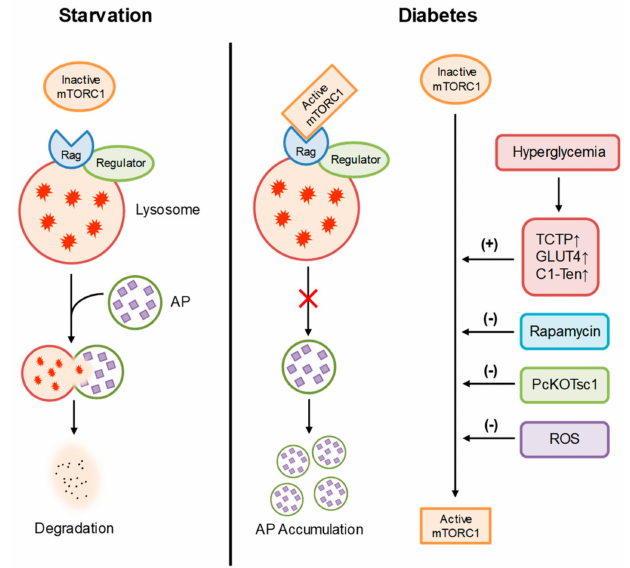
Figure 2. Regulation of mTORC1 in podocytes. During starvation, inactive mTORC1 has no e ff ects on lysosome function and autophagic flux in podocytes. During diabetic nephropathy (DN), hyperglycemia upregulates TCTP, GLUT3, and C1-Ten, leading to overactivation of mTORC1 and inhibition of autophagy. As a specific mTORC1 inhibitor, rapamycin can prevent lysosome dysfunction, autophagic deficiency, and podocyte injury during diabetes. Reactive oxygen species (ROS) produced by mitochondria has also been reported to prevent mTORC1 activation in podocytes during diabetes. Lysosome membrane permeabilization (LMP) has been found to initiate lysosome-dependent cell death [124]. Lysosome contents including cathepsins as the main stimulator of the cell death